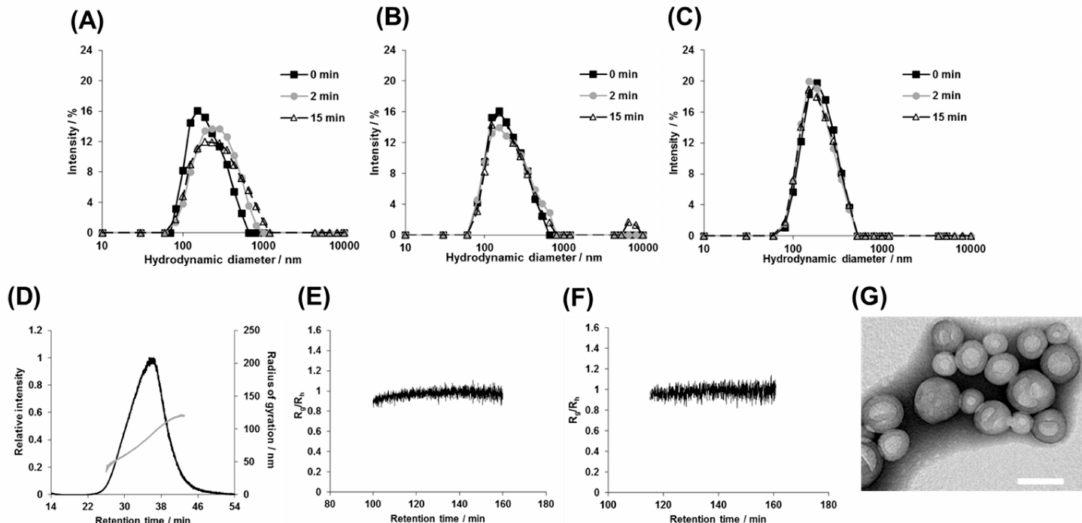
Figure 7. Structural changes in the polymersomes in response to photoirradiation. ( A – C ) DLS results of polymersomes ( A ) 1b , ( B ) 2 , and ( C ) 5 , irradiated for 0 ( (cid:4) ), 2 (gray, (cid:7) ) and 15 min ( ∆ ). ( D ) An AF4 fractogram of polymersome 2 after irradiation for 15 min. ( E , F ) Time profiles of the shape factor (Rg / Rh), determined from AF4 fractograms, of polymersomes ( E ) 2 and ( F ) 5 after irradiation for 15 min. ( G ) TEM image of polymersome 1b after irradiation for 15 min. Scale bar = 100